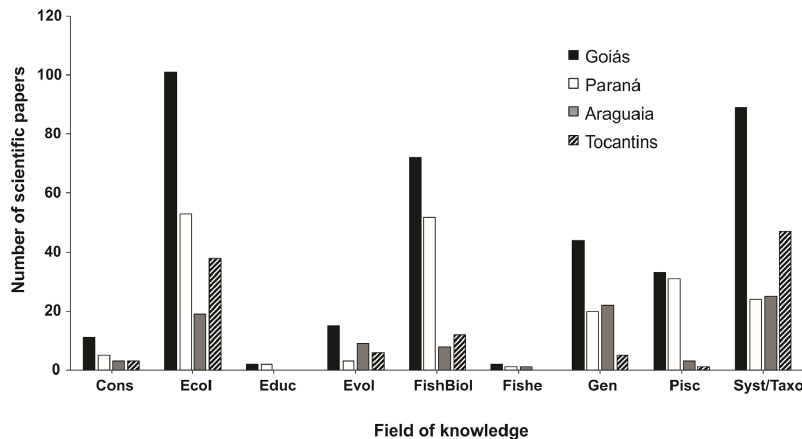
Figure 2. Number of scientific papers by field of knowledge and river basin in Goiás State. Cons=Conservation, Ecol=Ecology, Educ=Education, Evol=Evolution, FishBiol=Fish Biology, Fishe=Fisheries, Gen=Genetic, Pisc=Pisciculture and Syst/Taxo=Systematics/Taxonomy.